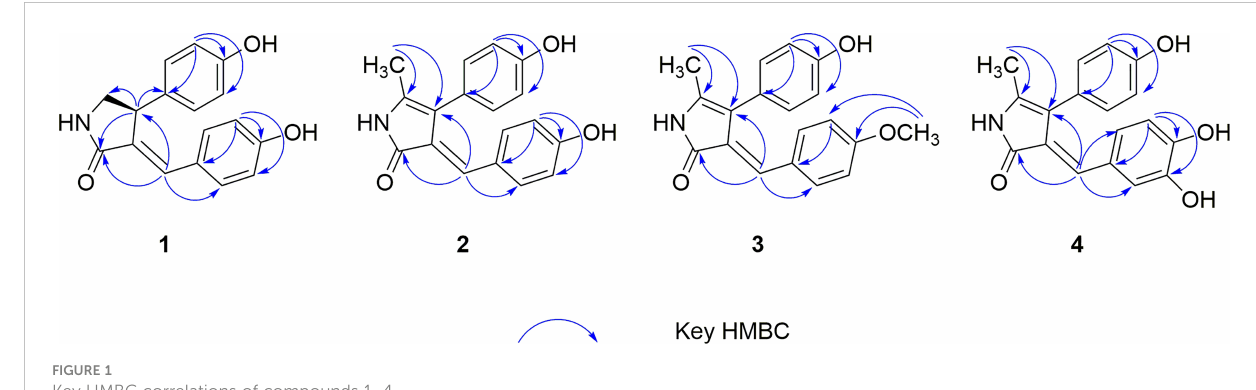
FIGURE 1 Key HMBC correlations of compounds 1 −